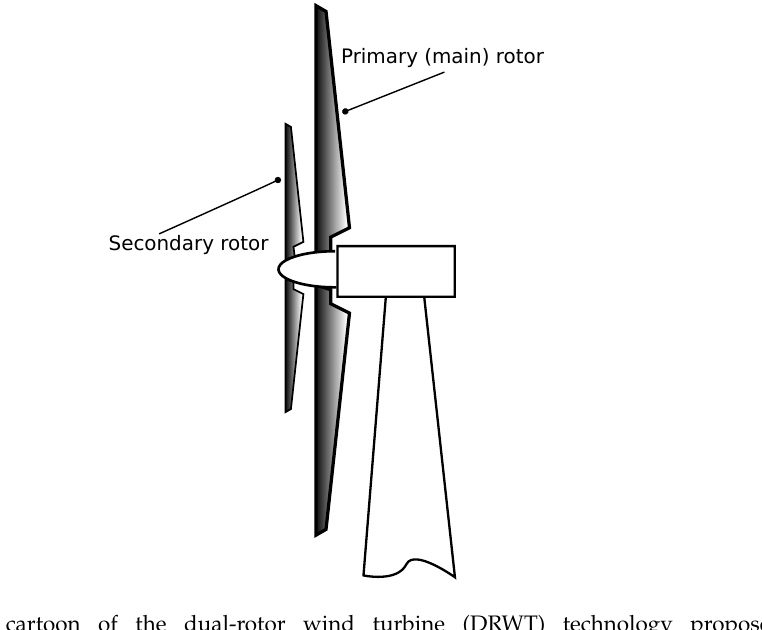
Figure 1. A cartoon of the dual-rotor wind turbine (DRWT) technology proposed by Rosenberg et al.